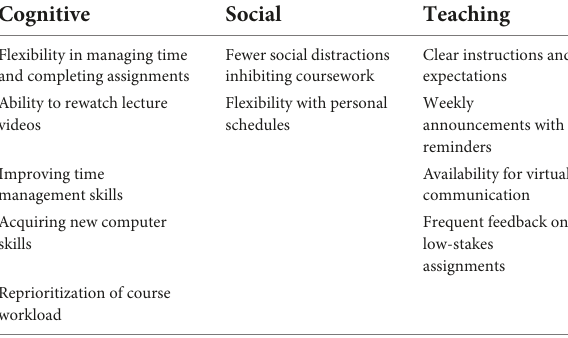
TABLE 2 Students’ perceived benefits of the emergency remote teaching (ERT)